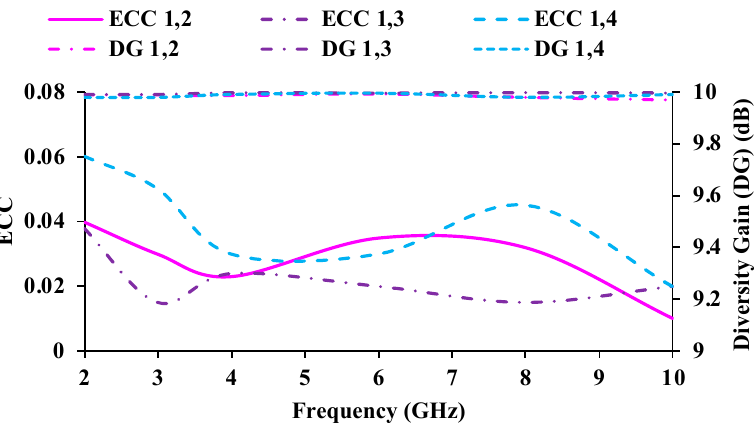
Figure 14. ECC and diversity gain plots of the MIMO antenna.